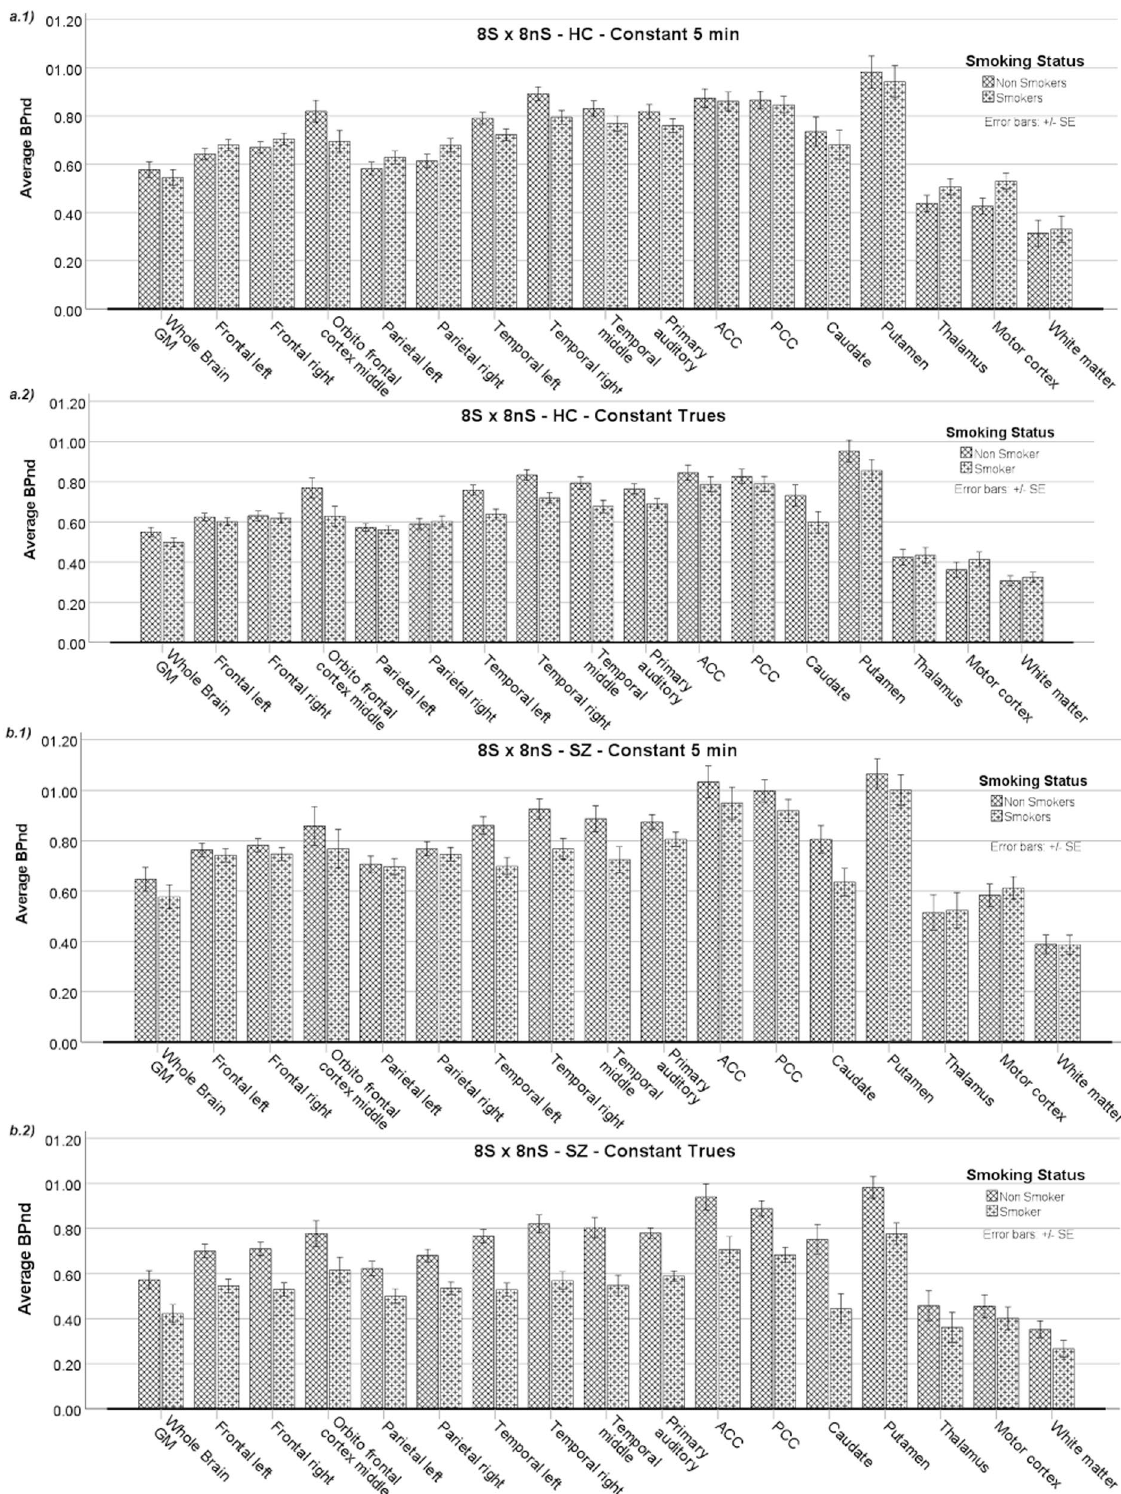
Fig. 2 Smoking effects on BP ND for HC and SZ groups showed individually for both framing schemes. The Average BP ND for balanced subgroups according to smoking status is shown in: a.1 For HC and ‘Const 5 min’ framing scheme, a.2 For HC and ‘Const Trues’ framing scheme, b.1 For SZ and ‘Const 5 min’ and b.2 For SZ and ‘Const Trues’ framing